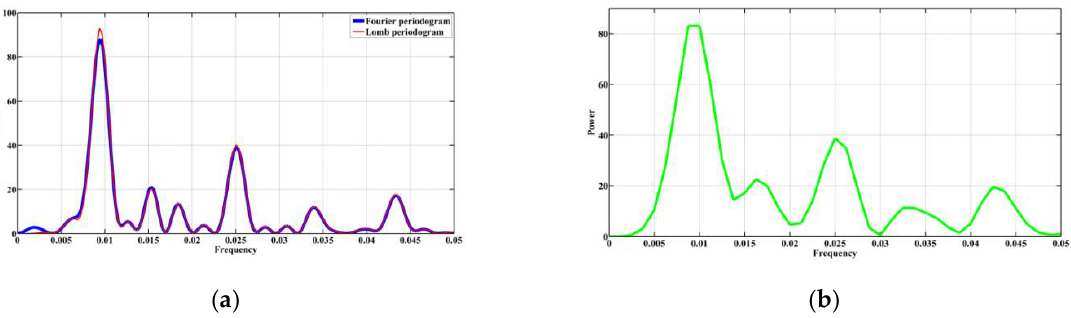
Figure 3. ( a ) Fourier and Lomb periodograms; ( b ) REDFIT spectrum. Constructed for the time series in Figure 1.